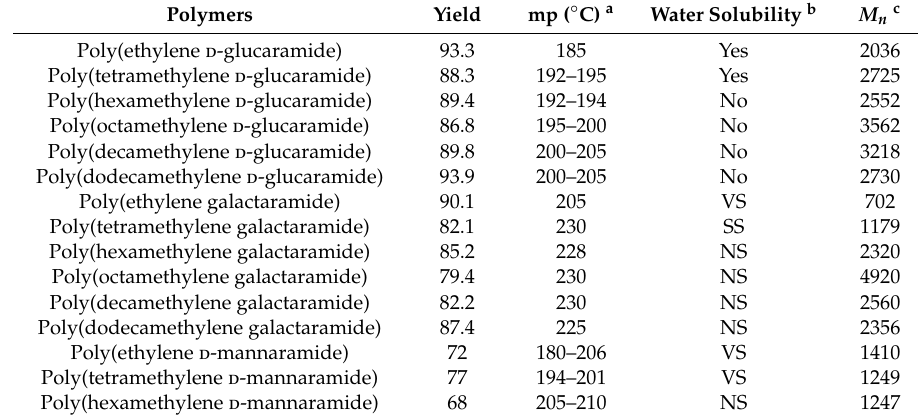
Table 1. Isolated yields, melting points, and water solubility of poly(alkylene hexaramide)s [31]. The original tables have been combined into this